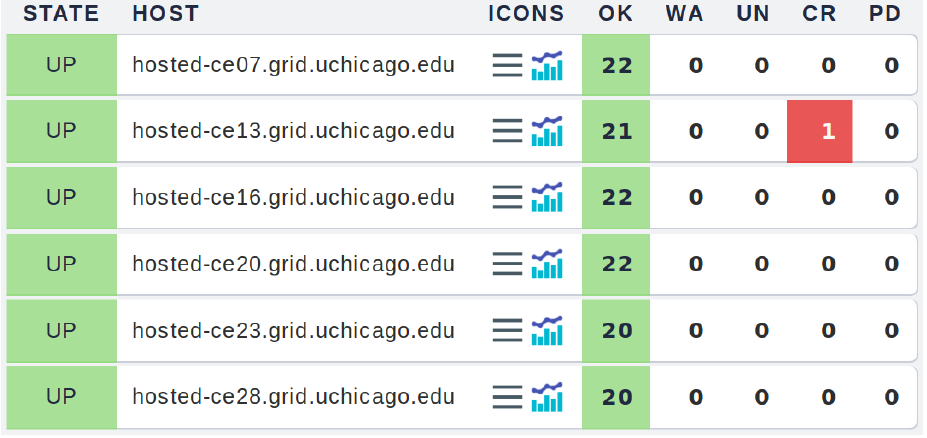
Figure 2. The Check_MK